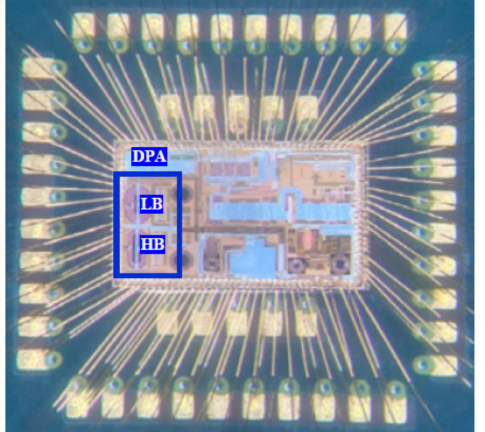
Figure 12. Chip-micrograph of the fabricated